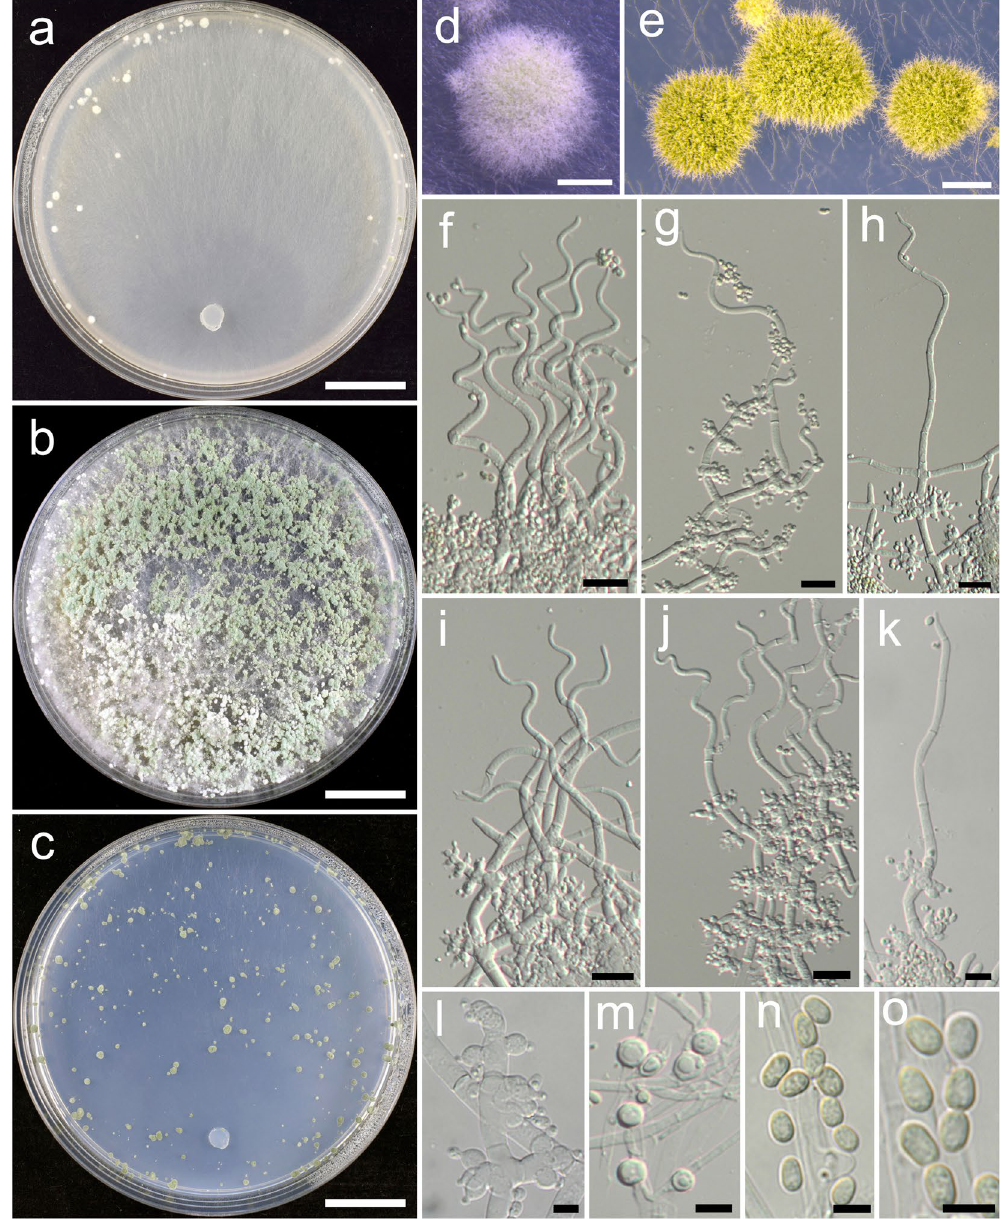
Figure 11. Trichoderma hainanense (HMAS 248837). ( a–c ) Cultures at 25 °C, 10 d (a. on CMD; b. on PDA; c. on SNA); ( d–e ) Conidial pustules (d. CMD, 7 d; e. SNA, 7 d); ( f–l ) Conidiophores and phialides (SNA, 6 d); (m) Chlamydospores (SNA, 6 d); (n–o) Conidia (SNA, 6 d). Bars: a–c = 20 mm. d–e = 400 μ m. f–j = 20 μ m. k , m = 10 μ m. l, n, o = 5 μ